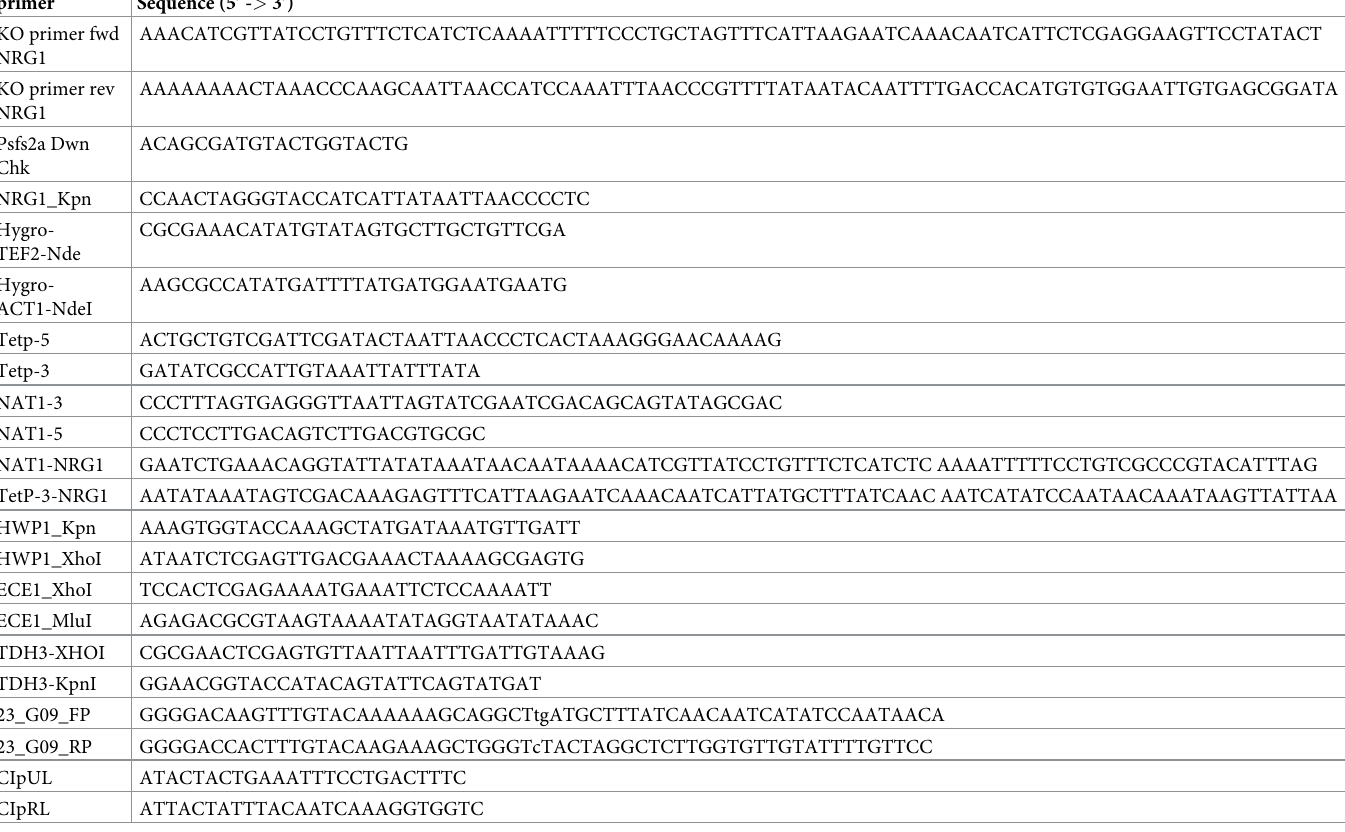
Table 2. Primers used for generating C. albicans